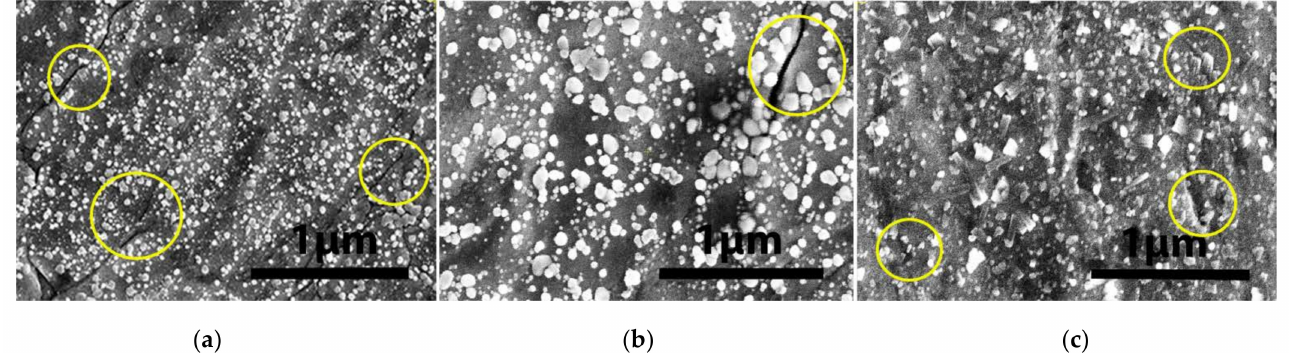
Figure 7. High-magnification SEM images of irradiated samples for a duration of 10 min in the 6 MeV EB: ( a ) pure W laminate ( × 50,000), ( b ) (W-K) 1 laminate( × 50,000) and ( c ) (W-K) 2 laminate( × 50,000). Large cracks are observed on the surfaces marked with